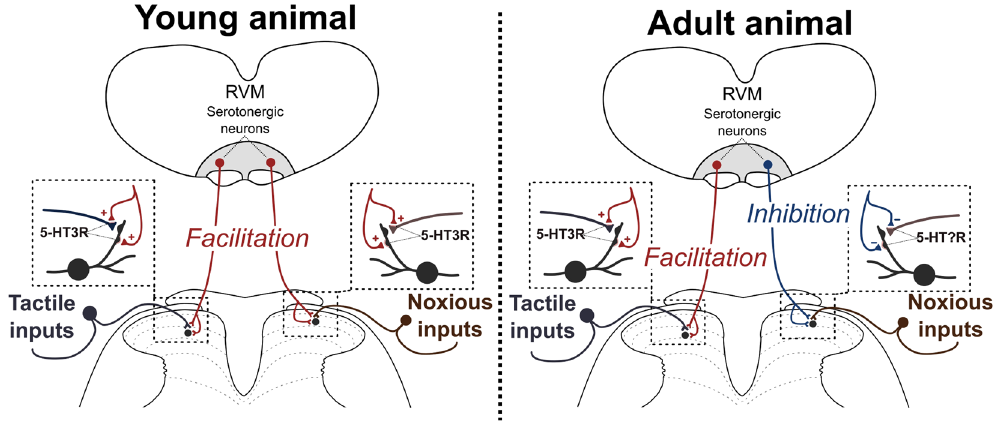
Figure 6. A proposed model of serotonergic descending modulation of spinal somatosensation. In young animals (P21), descending serotonergic modulation facilitates tactile and noxious inputs to the dorsal horn via activation of 5-HT 3 Rs. In adults, descending serotonergic and 5-HT 3 R-mediated facilitation of tactile inputs is also observed; however, noxious inputs are now inhibited by descending serotonergic neurons via a different 5-HTR